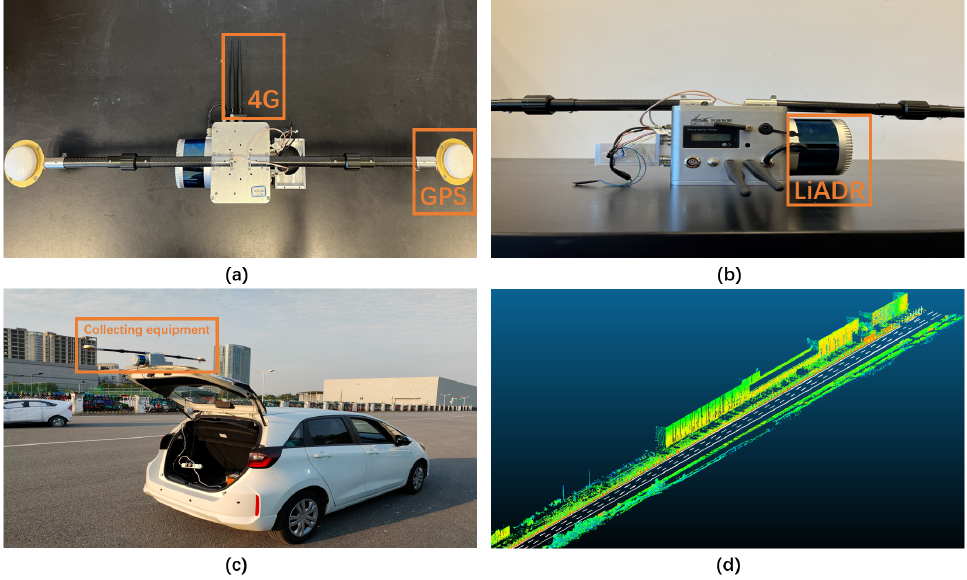
Figure 7. ( a ) Top view of portable map collecting equipment; ( b ) main view of portable map collecting equipment; ( c ) vehicles equipped with collection equipment; ( d ) collected point cloud